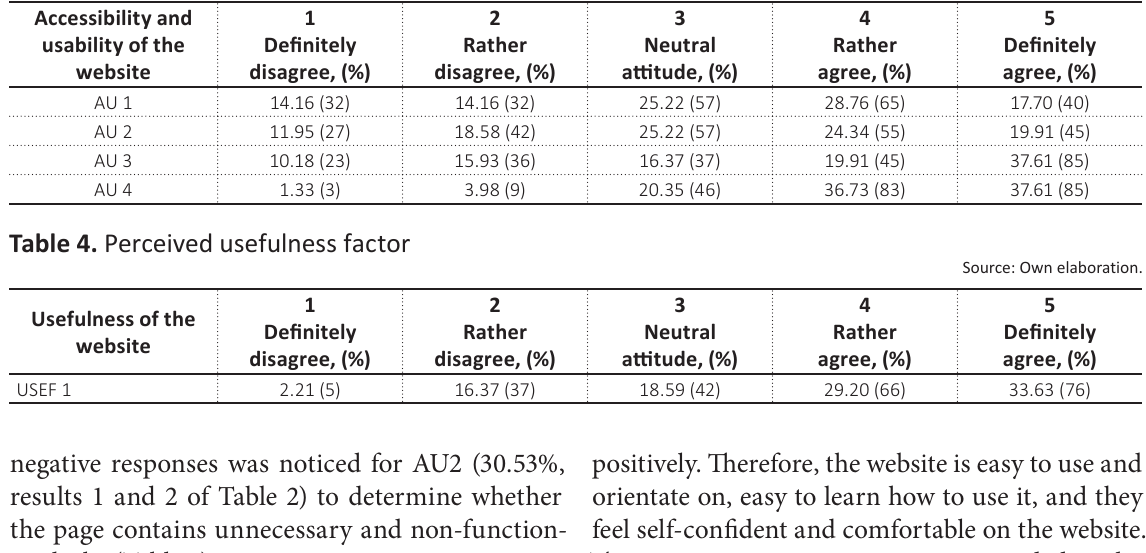
Source: Own elaboration.